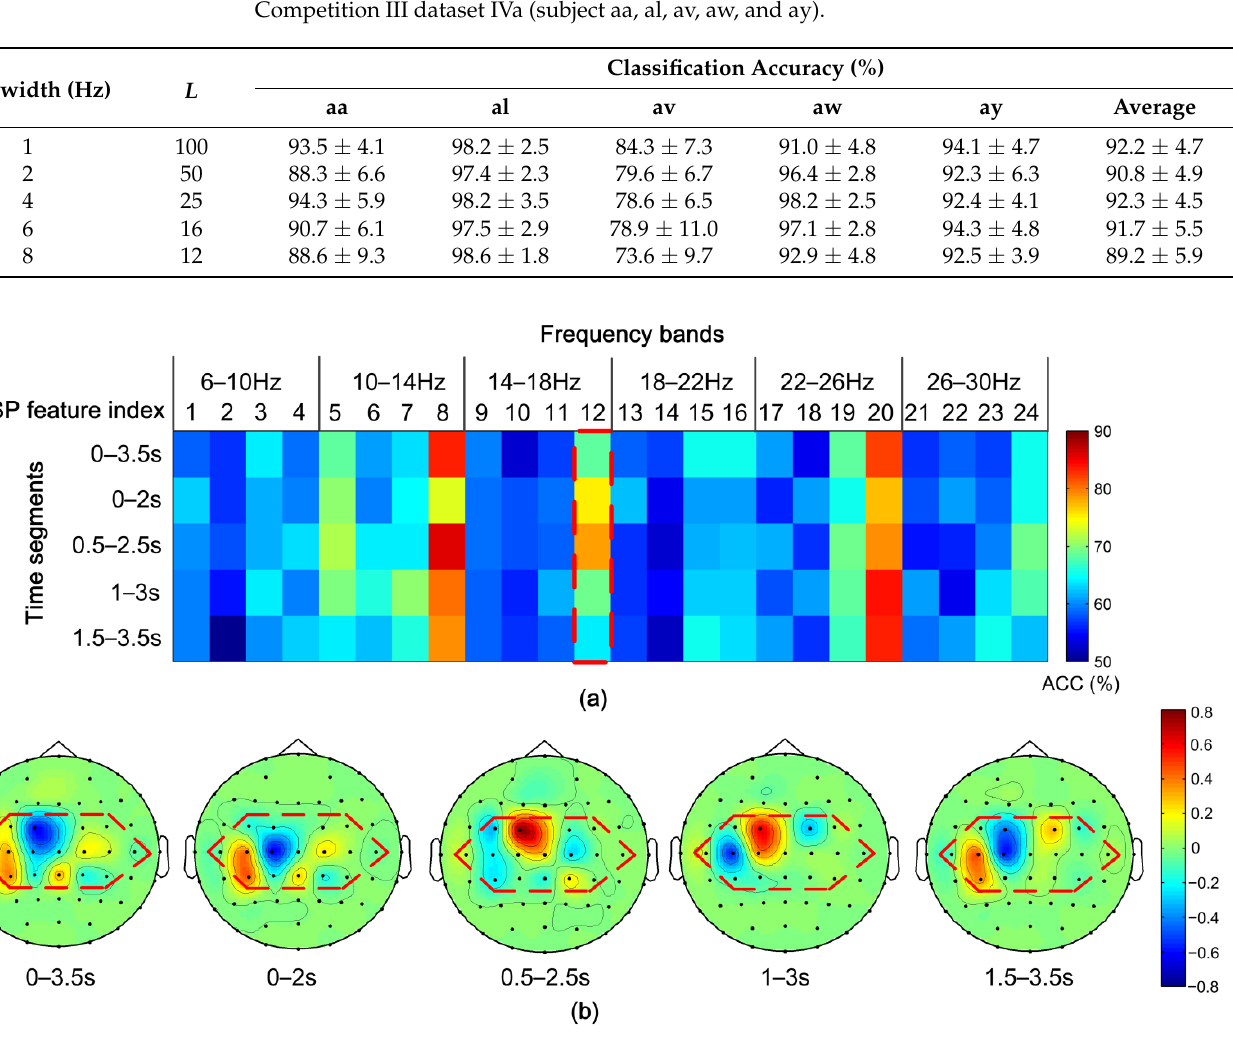
Figure 6. Performance of time segmentation for subject aa. ( a ) Pictorial representation of the classification accuracy (ACC) on the feature space learned by the proposed method for subject aa. Each time-frequency segment contains 4 CSP features. ( b ) The topographical maps of the most significant spatial filter learned by the CSP from all time windows in sub-band 14 – 18 Hz (marked by red outline in Figure 6a). Electrodes inside red outline in Figure 6b represent the electrodes of the sensorimotor area.